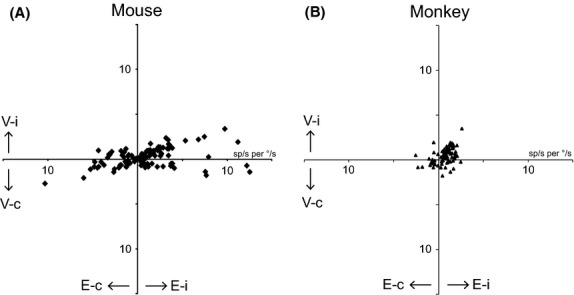
Subclassification of floccular Purkinje cells according to their sensitivity to eye velocity (abscissa) and head velocity (ordinate), for Purkinje cells in mice, recorded in this study (A), and Purkinje cells in monkey, adapted from Raymond and Lisberger (1997) (B). E-i: Eye-ipsiversive; E-c: Eye-contraversive; V-i: Vestibular-ipsiversive; V-c: Vestibular-contraversive.